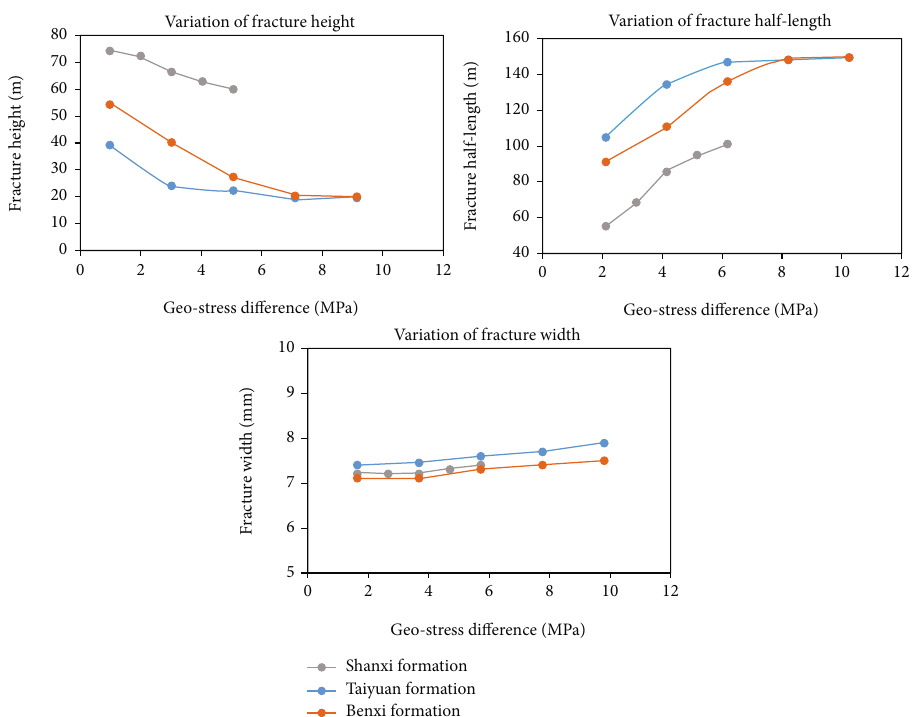
Figure 6: Variation of hydraulic fracture shape with the geostress di ff erence.